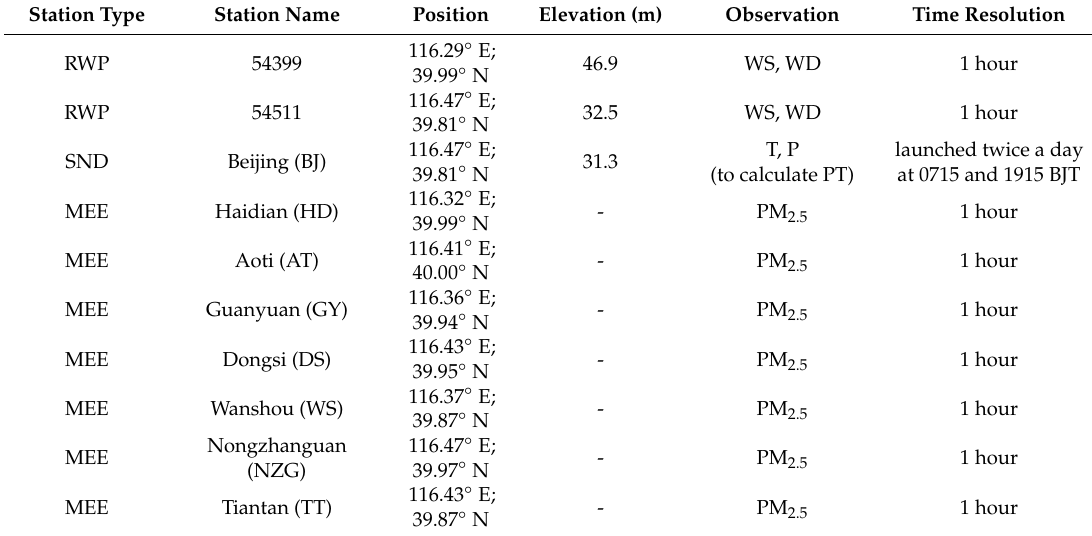
Table 2. Basic information for observation